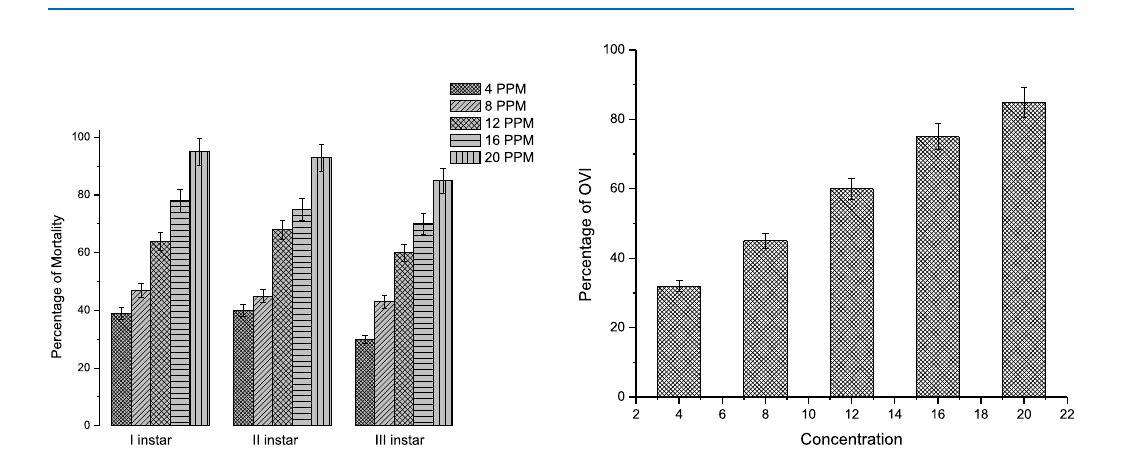
Fig. 6. Percentage mortality of crude from Caryota urens different concentration with different instars